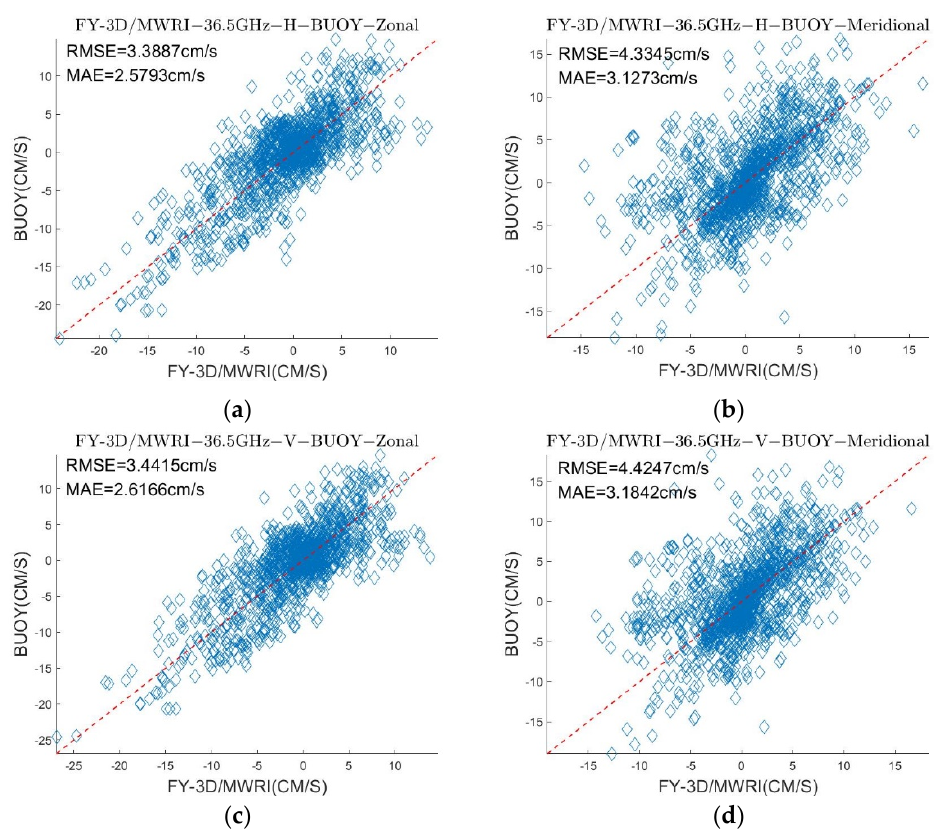
Figure 6. Comparison between the sea ice motion, retrieved from FY ‐ 3D/MWRI T b data at 36.5 GHz with different polarizations, and the motion of the buoy. ( a ) is a scatter diagram of the sea ice motion retrieved by using FY ‐ 3D/MWRI T b data at 36.5 GHz with H polarization and the motion of the buoy in the zonal direction, ( b ) is a scatter diagram of the sea ice motion retrieved by using FY ‐ 3D/MWRI T b data at 36.5 GHz with H polarization and the motion of the buoy in the meridional direction, ( c )